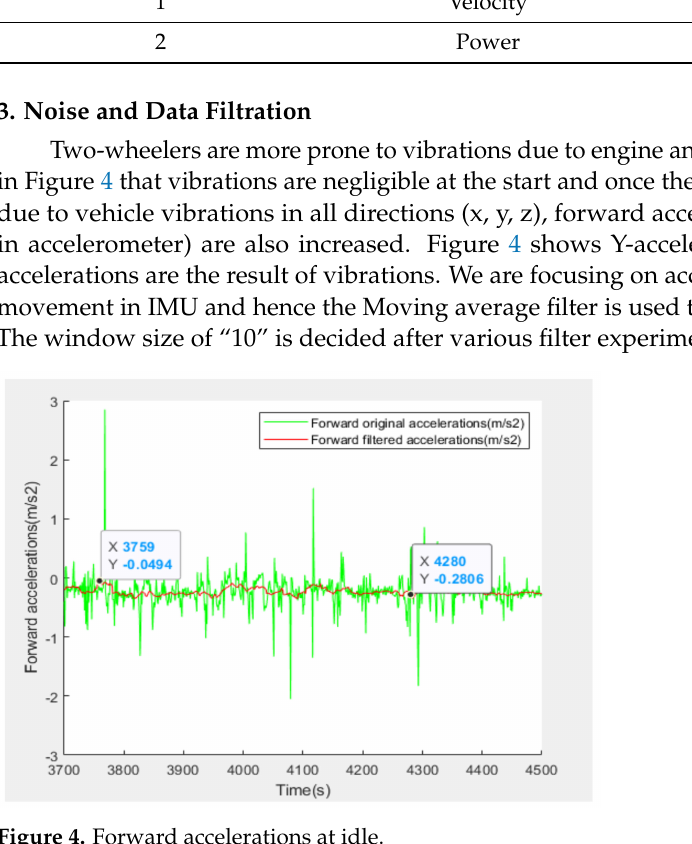
Table 2. Estimated uncertainties of estimated parameters. Sr. No.